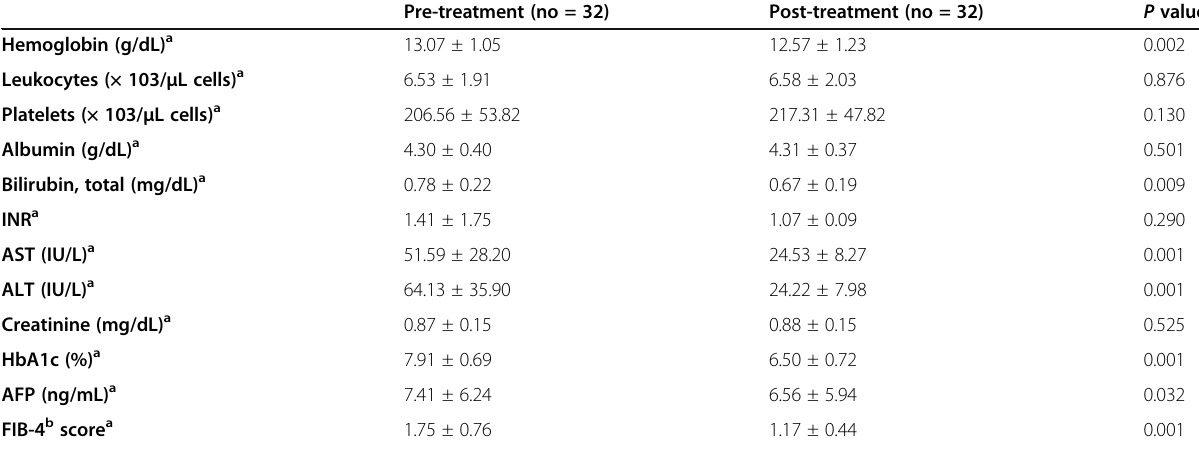
Table 3 Statistical comparison between pre-treatment and post-treatment parameters in glycemic improved patients Pre-treatment (no = 32) Post-treatment (no =